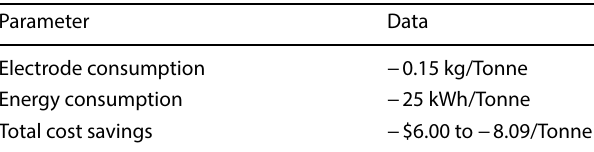
Table 3 Cost and energy savings observed by increasing % metal- lization in DRI